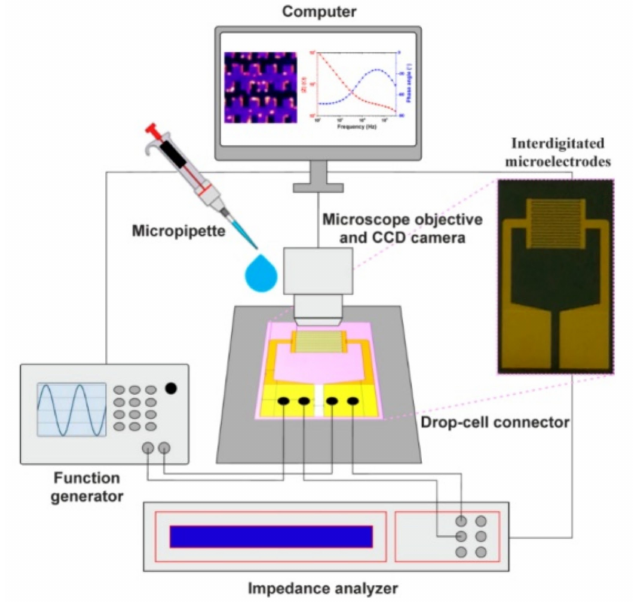
Figure 7. Experimental setup of DEP manipulation and EIS method. The EIS measurement results are usually in the form of Nyquist or Bode plots. Reprinted with permission from Ref. [97], ©MDPI